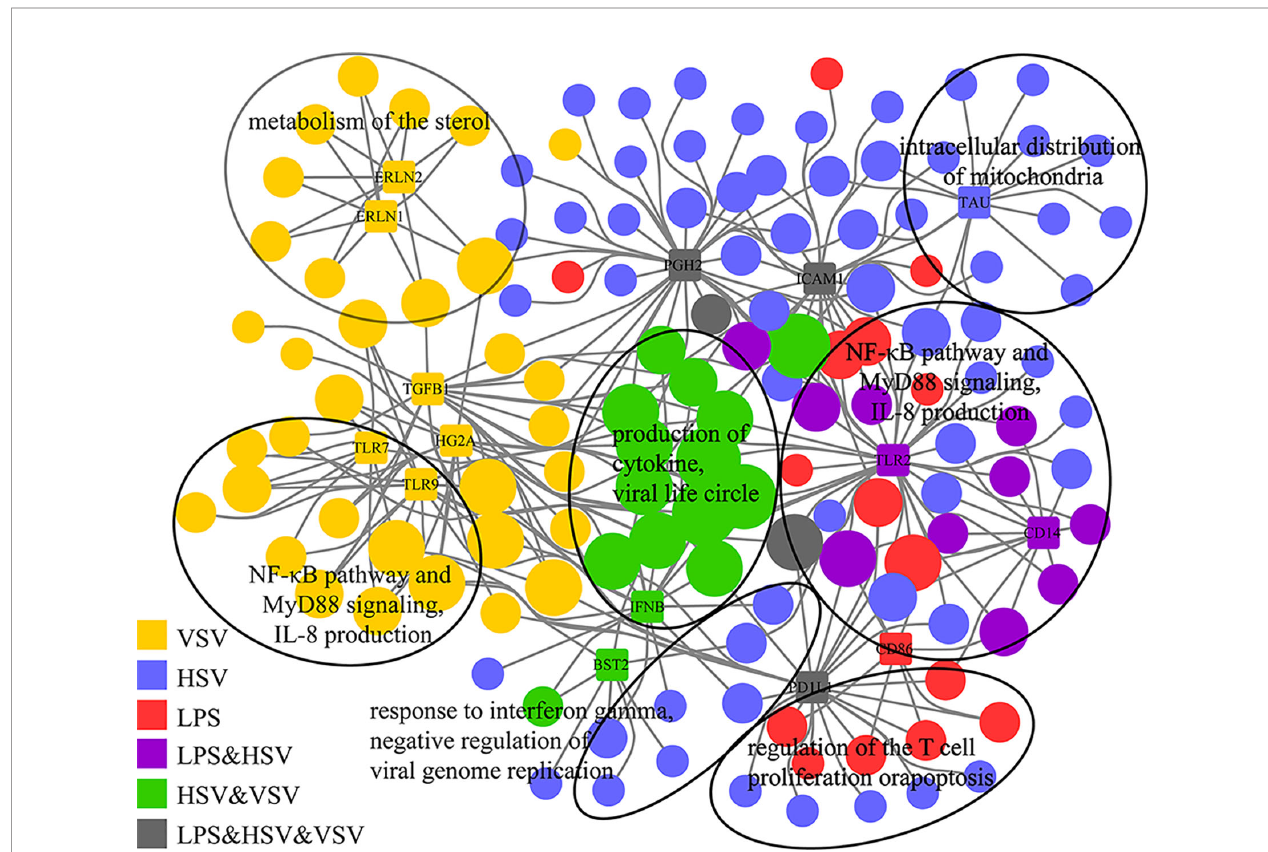
FIGURE 4 | Gene-concept networks of glycoproteomics. Gene-concept network of signi fi cant GO terms enriched by consistently upregulated glycoproteins (grouped in Figure 3C ) and their associations with top-related glycoproteins. The glycoproteins are represented by colored rectangles with the protein names in the center. Enriched GO terms are represented by colored circles. Colors illustrates changed glycoproteins under different stimulations (single or combinational). The size of each circle is proportional to the number of belonging to multiple annotation